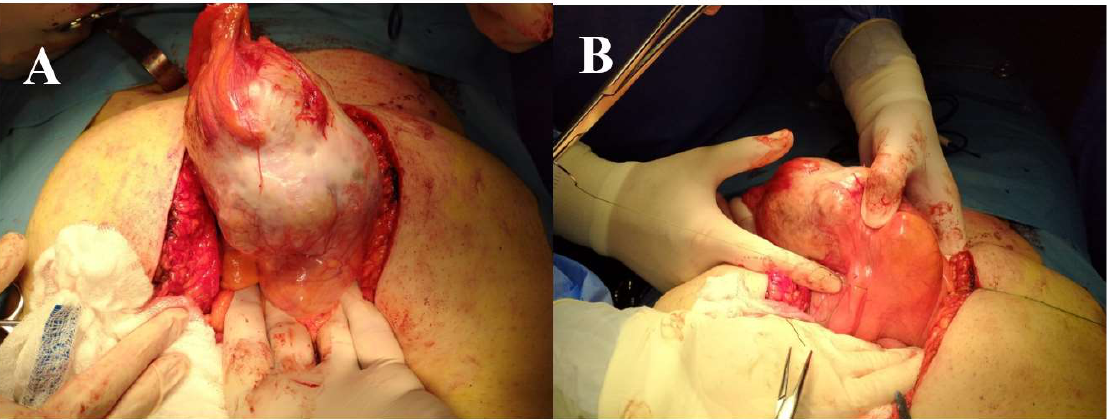
Figure 3. ( A ). Macroscopic aspect of tumor: the suprapubic mass consisted of solid and cystic lesions. ( B ). Tumoral cystic mass adherent to antero-superior wall of the bladder.